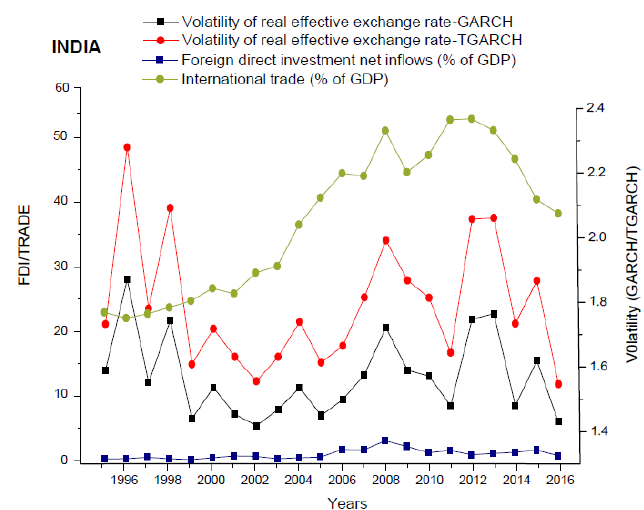
Figure 3. Exchange Rate Volatility vs. FDI/Trade (India).